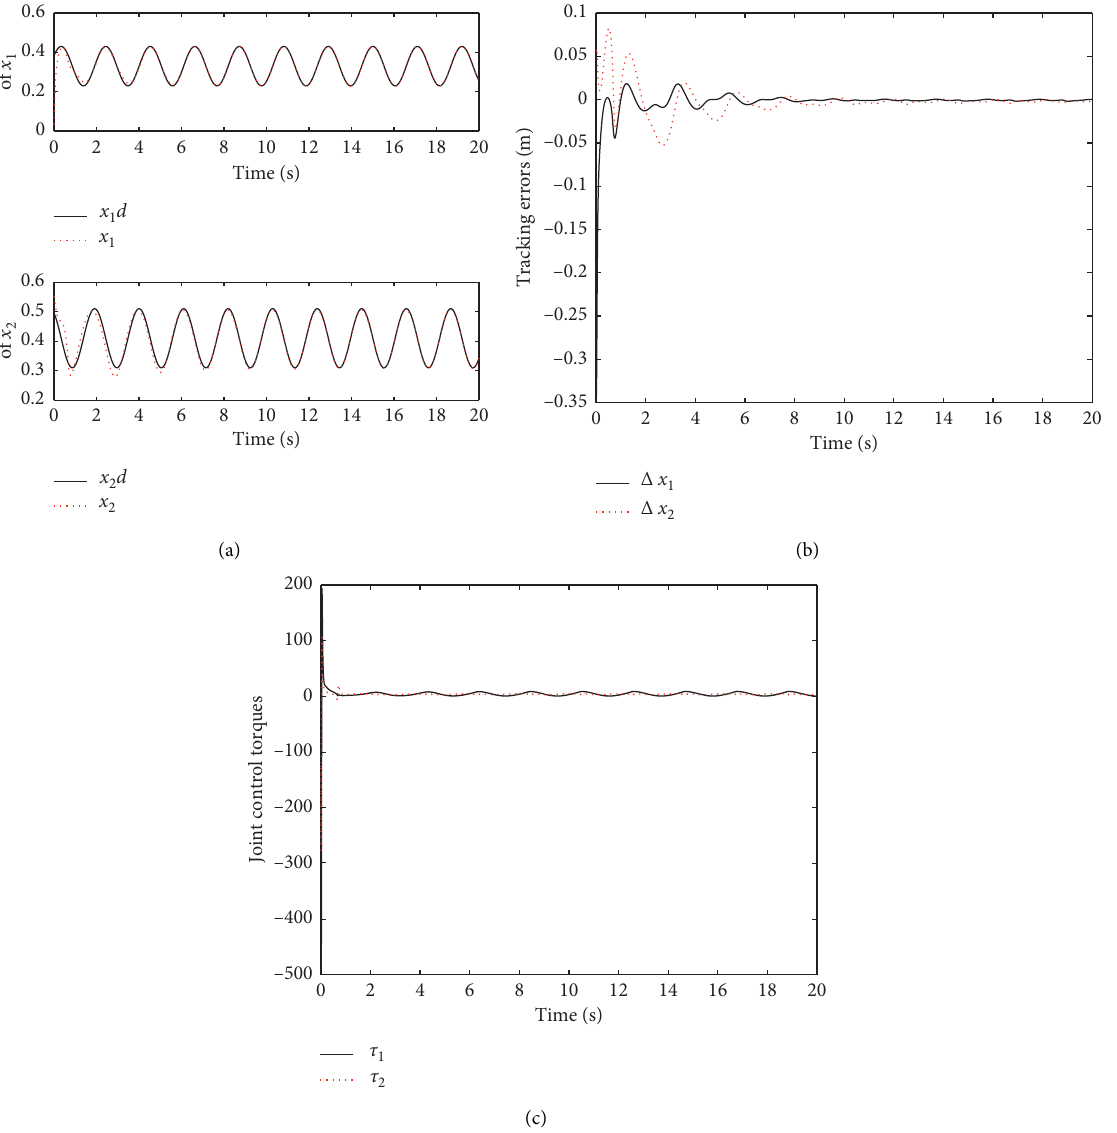
Figure 1: End-effector position tracking performance without actuator parameters perturbation. (a) Tracking performance. (b) Tracking errors. (c) Control